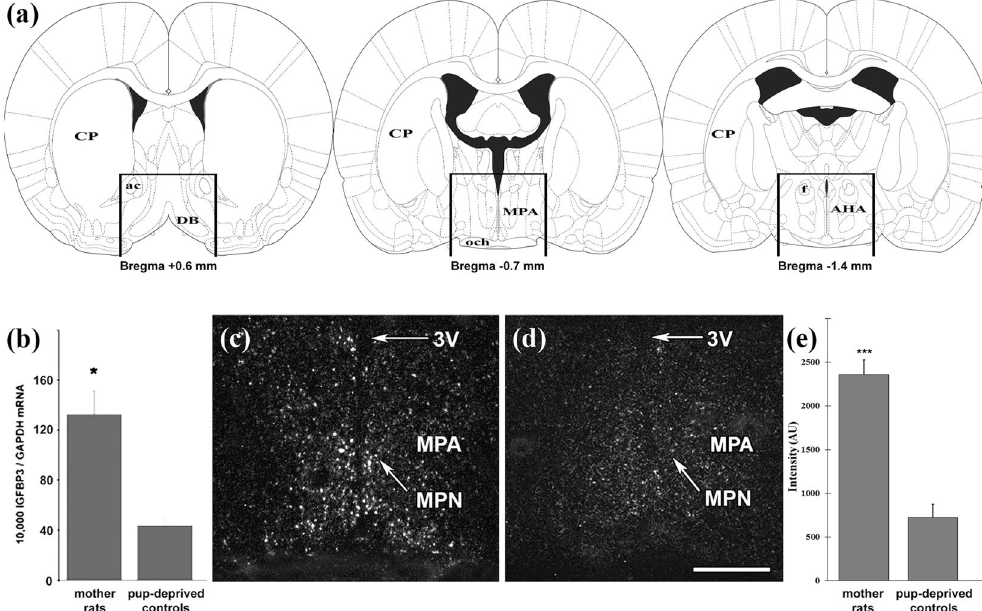
Figure 1. Induction of IGFBP-3 in the preoptic area of lactating rat mothers. ( a ) Schematic figures show the dissected area, which was used for RT-PCR validation of the microarray data. The rostral and caudal borders of the dissected area were at + 0.6 and − 1.4 mm from the bregma, respectively. A dorsal horizontal cut was made immediately above the level of the anterior commissure, and the lateral borders were cut 2 mm lateral to the midline. ( b ) IGFBP-3 mRNA level was 3 times higher in the preoptic area of rat dams (n = 9) compared with that in the preoptic area of pup-deprived controls (n = 8; * : p < 0.05). Data are presented as the ratio to GAPDH mRNA levels as the mean values ± SEM. ( c,d ) Dark-field photomicrographs of IGFBP-3 in situ hybridization histochemistry show that the IGFBP-3 mRNA hybridization signal (white) was elevated in rat dams ( c ) compared with that in pup-deprived rat mothers ( d ) in the medial preoptic area (MPA) and the medial preoptic nucleus (MPN). ( e ) Densitometric analysis shows that the IGFBP-3 labelling intensity is significantly elevated in the MPA of lactating mothers compared with that in pup-deprived controls (n = 6–6; *** p < 0.001, p = 0.00002). Density is expressed in arbitrary units (AU). The results are presented as the mean values ± SEM. Further abbreviations: 3 V – third ventricle; ac – anterior commissure; AHA – anterior hypothalamic area; CP – caudate putamen; DB – diagonal band; f – fornix; och – optic chiasm. Scale bar = 400 µ